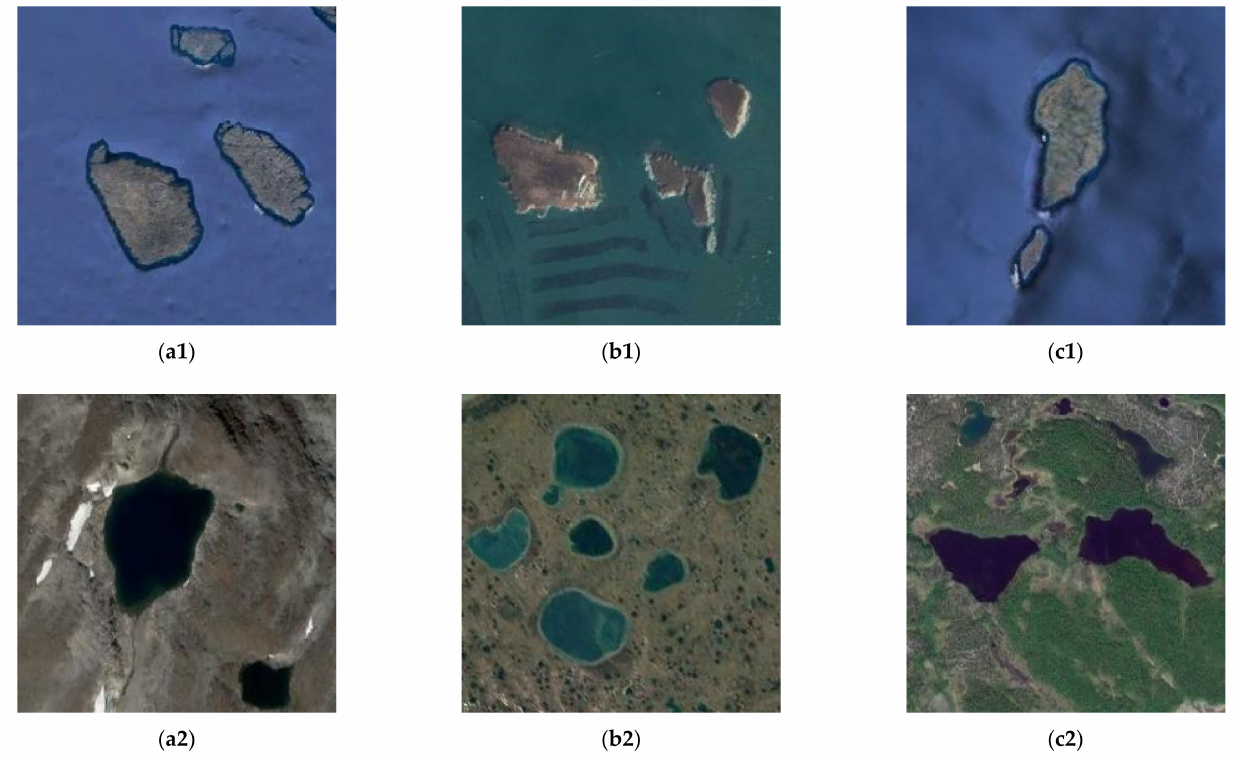
Figure 13. Multispectral remote sensing images: ( a1 ) Island image 1; ( b1 ) Island image 2; ( c1 ) Island image 3; ( a2 ) Lake image 1; ( b2 ) Lake image 2; ( c2 ) Lake image